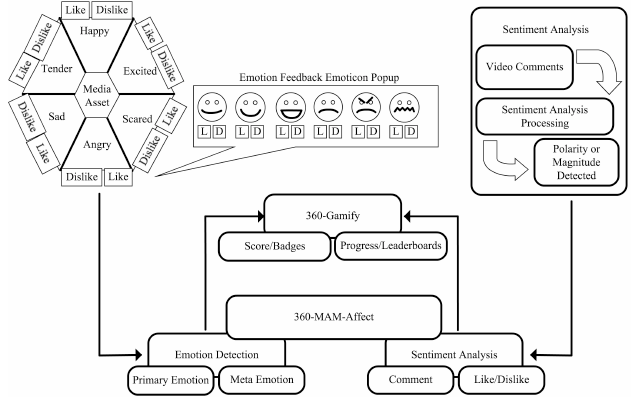
Figure 2. Archiecture of